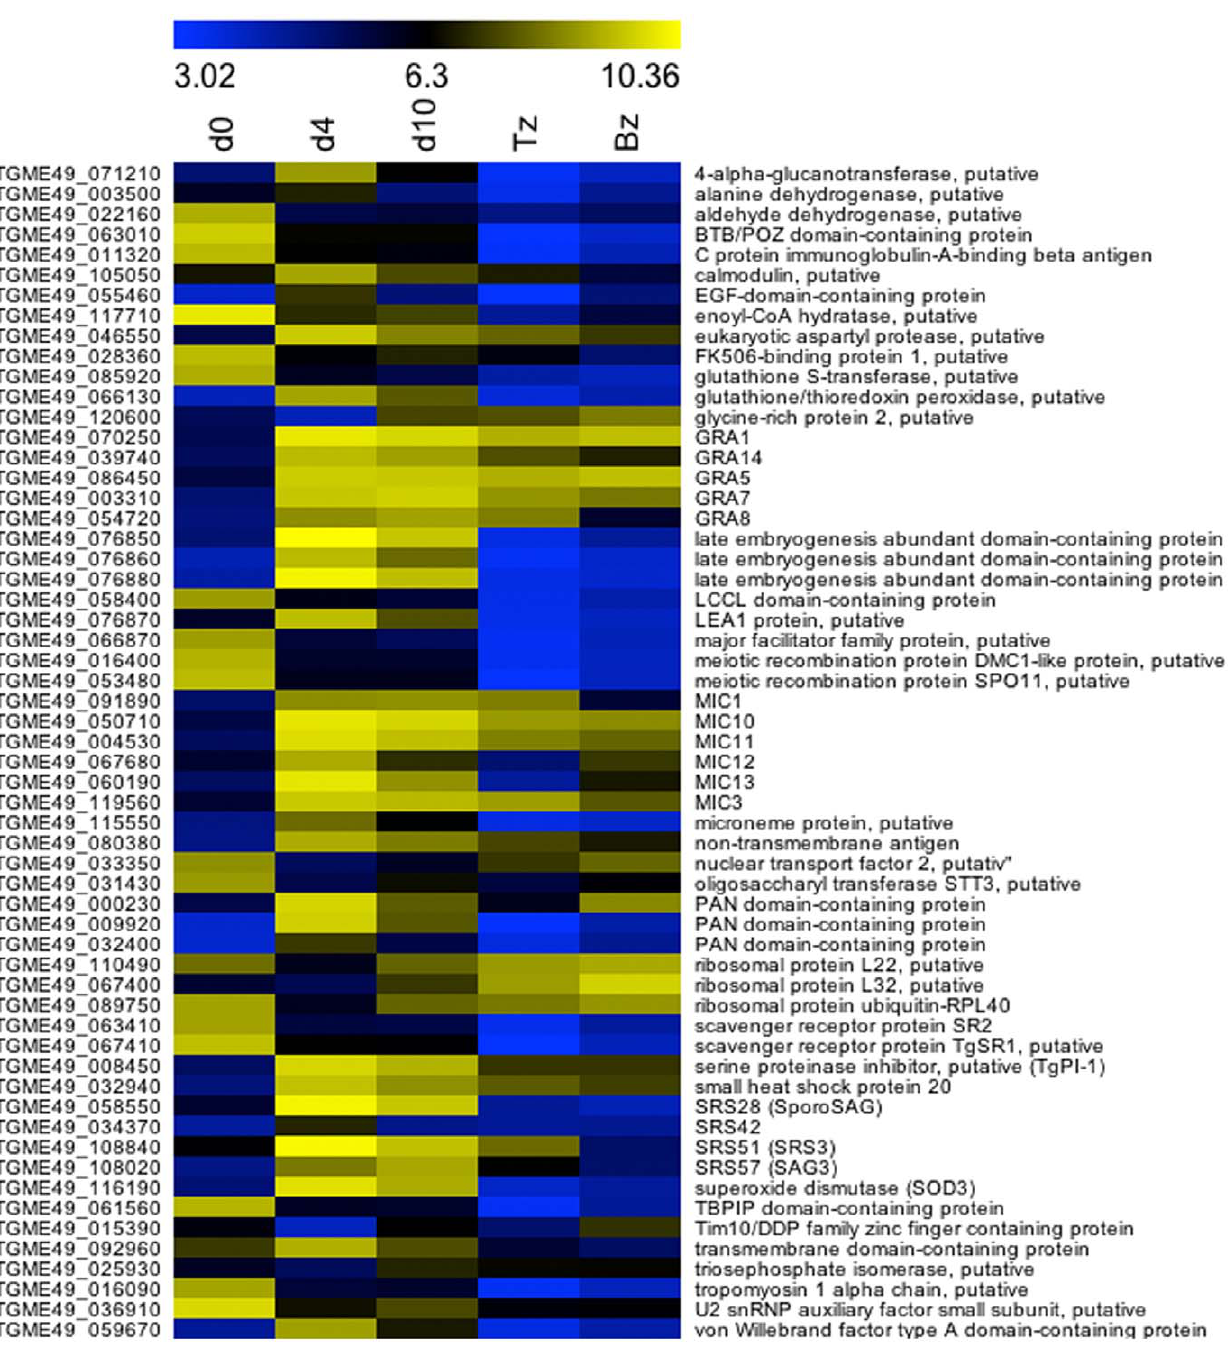
Figure 3. Heatmap of the average normalized expression values (glog) of the top 30 genes with significantly changing expression levels, higher and lower, across all pair-wise comparisons of oocyst time points (ribosomal and hypothetical genes not included, shown in figure 2). Expression values for tachyzoite and bradyzoite stages were included to highlight genes that appear to be oocyst-specific and those that resemble tachyzoites and/or bradyzoites in their transcript levels. The range of expression is represented by a color grade ranging from low (blue) to high (yellow). doi:10.1371/journal.pone.0029998.g003 or SporoSAG [45], but the surface antigen repertoire of the first Toxoplasma surface antigen to have its cognate gene sequenced sporozoite is not limited to SporoSAG. Surface antigen genes and complete protein structure determined [50,51]. Although previously shown to be expressed in both sporozoites and varied in their specific immunogenicity and function, SRS proteins tachyzoites by SAGE and EST data include SAG1 , SAG3 and are involved in host cell invasion at the level of attachment and SRS3 [31]. Those results were confirmed in the microarray data recognition by the host cell (thereby influencing host immune reported here; Table 4 shows a complete list of SRS genes with response). The hallmark surface antigen in sporozoites is SRS28,